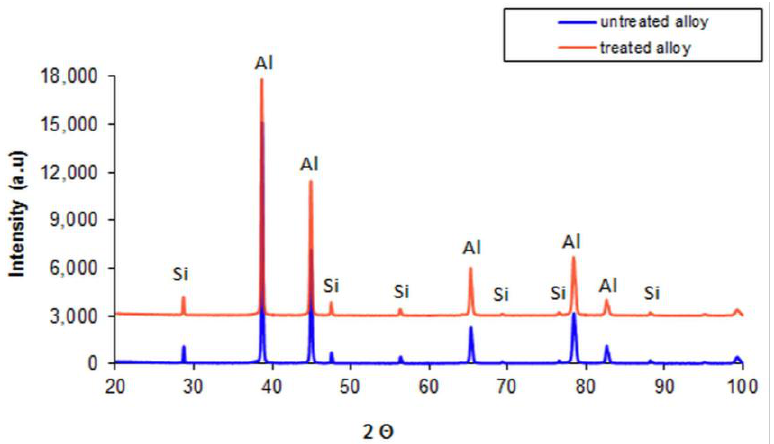
Figure 5. XRD patterns of A356 alloy before and after modification process by TiCN